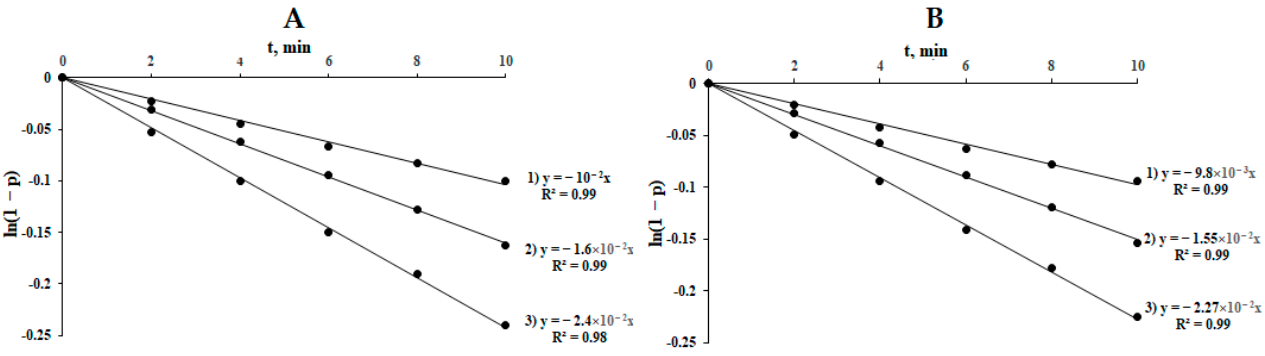
Figure 3. Linear dependences in coordinates ln (1 − p) vs. t in the presence of sulfanylethanoic acid ( A ) and 3-sulfanylpropanoic acid ( B ) at various initial initiator concentrations: 1—3.15 × 10 − 2 ; 2—6.30 × 10 − 2 ; 3—9.45 × 10 − 2 mol × l − 1 (the initial concentration of chain transfer agents is 0.47 mol × l − 1 , temperature is 343 K).